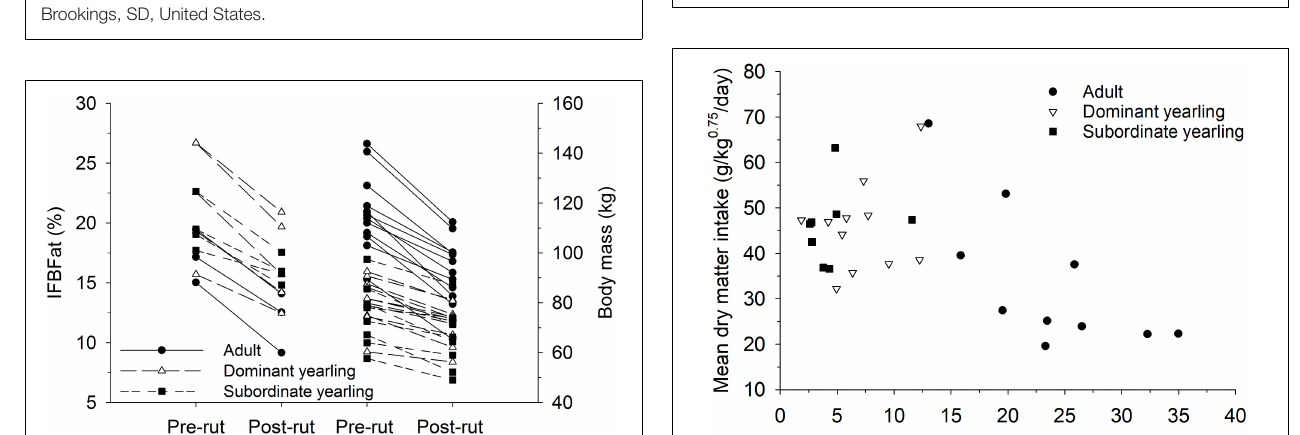
FIGURE 4 | Relationship between the cumulative change in body mass over the rut (mid-Oct to mid-Dec) and initial body mass (kg) in mid-Oct for adult ( ≥ 4.5-years old; n = 10), dominant yearling (1.5-years old and adult male absent; n = 11), and subordinate yearling (1.5-years old and adult male present; n = 9) white-tailed deer during 2006–2008 and 2010–2011, Brookings, SD, United States.